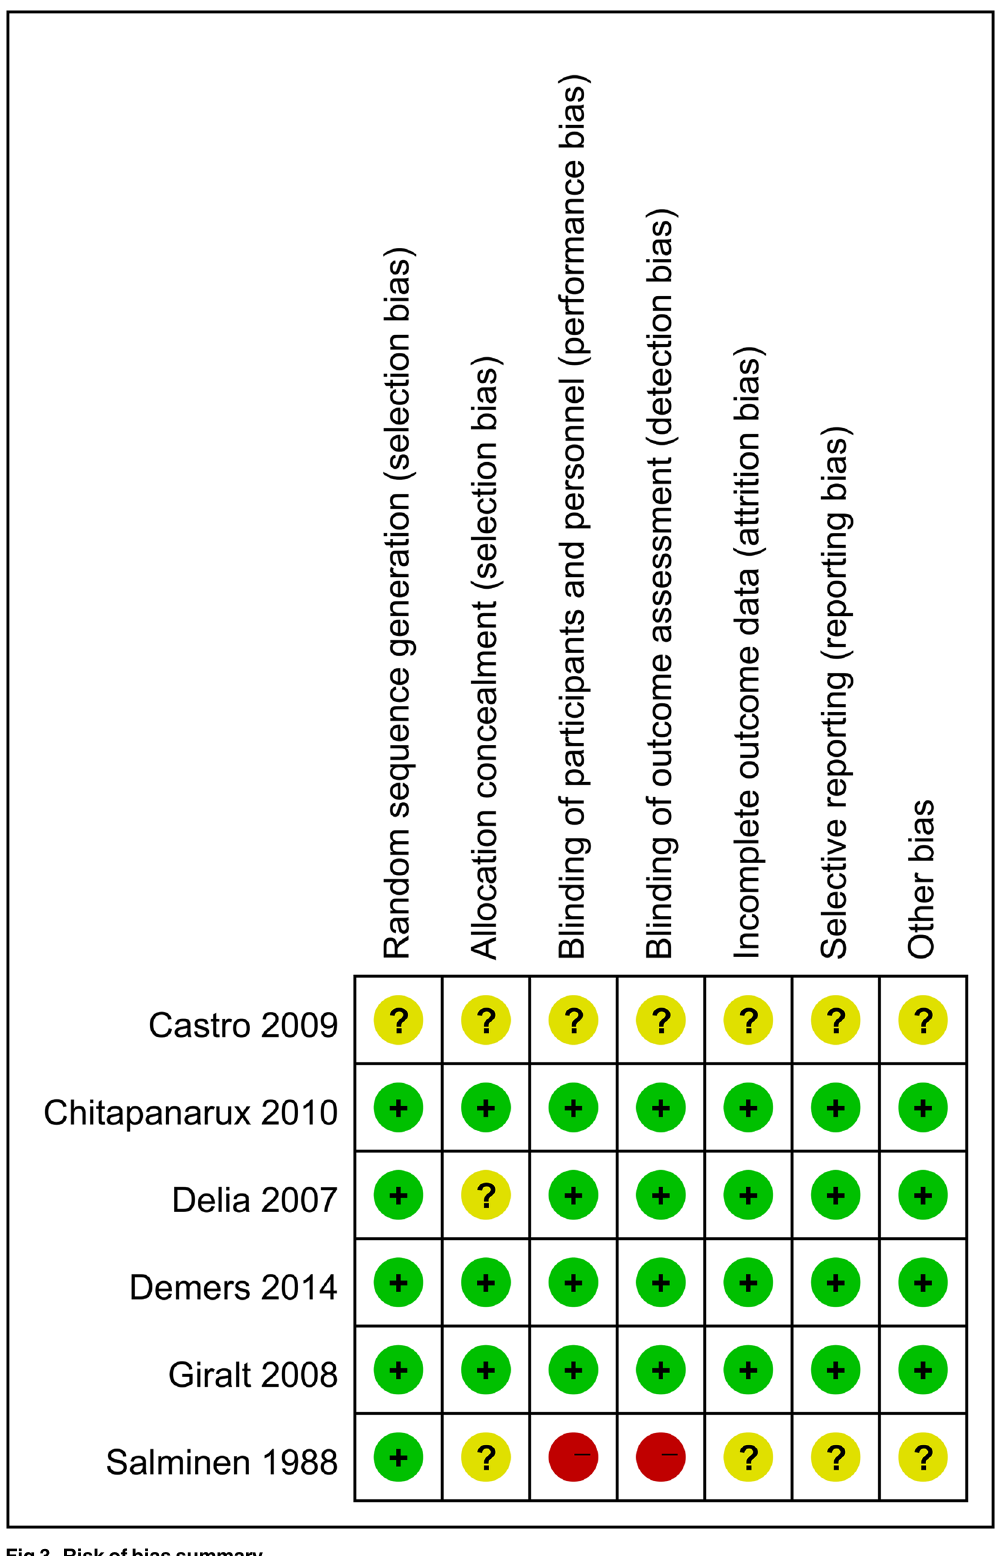
Fig 3. Risk of bias